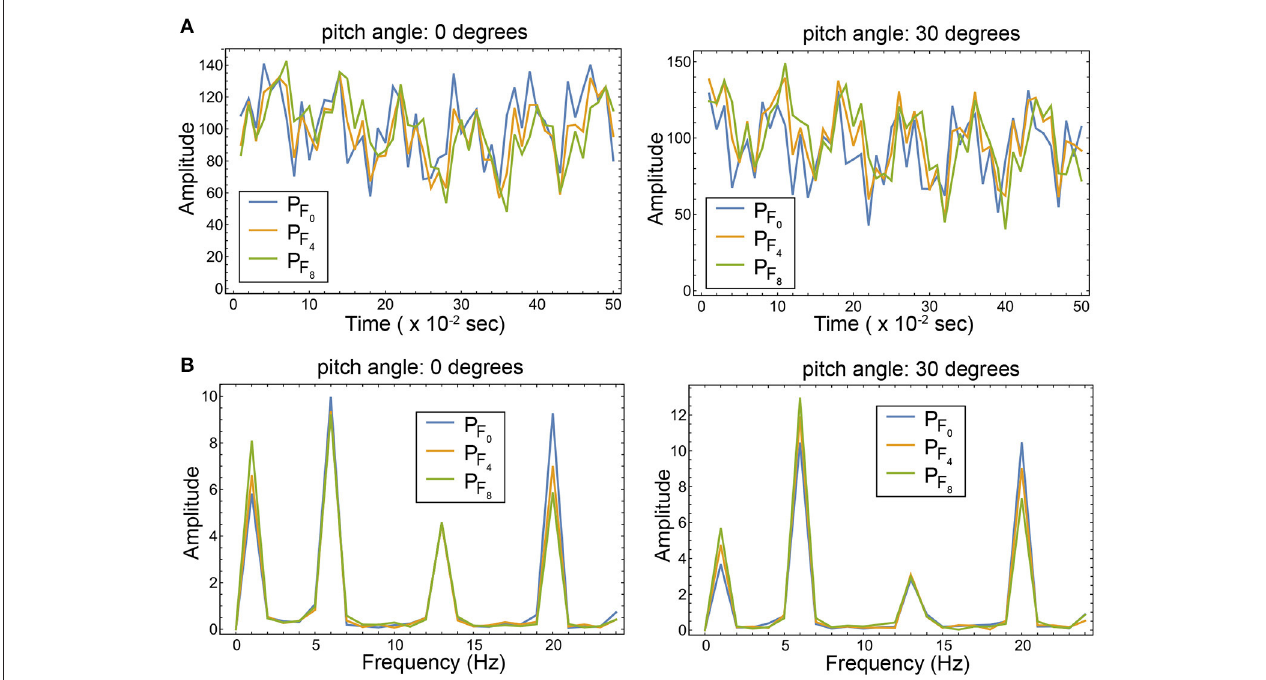
, P F , and P F represented in the (A) time and (B) frequency domains. Note that DC components are filtered out in 0 4 8